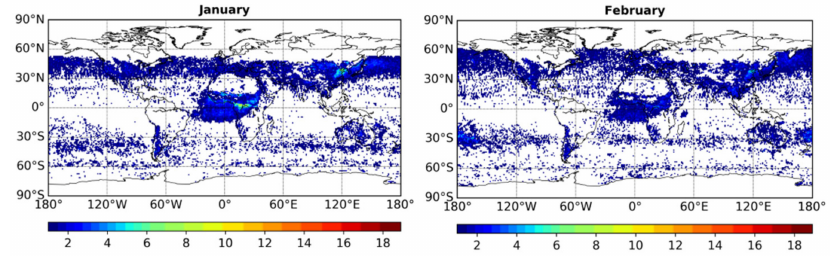
Figure 3. Global distribution of: ( a ) absolute frequency of occurrence of absorbing carbonaceous aerosols (in number of days / year); ( b ) relative percentage frequency of occurrence of absorbing carbonaceous aerosols (with respect to the number of days per year with available satellite data and for which the satellite algorithm operated). The results are averaged over the period 2005–2015. The white-shaded areas are those for which the algorithm did not operate due to missing input data (non-operating algorithm) or it did not detect ACA (non-detecting